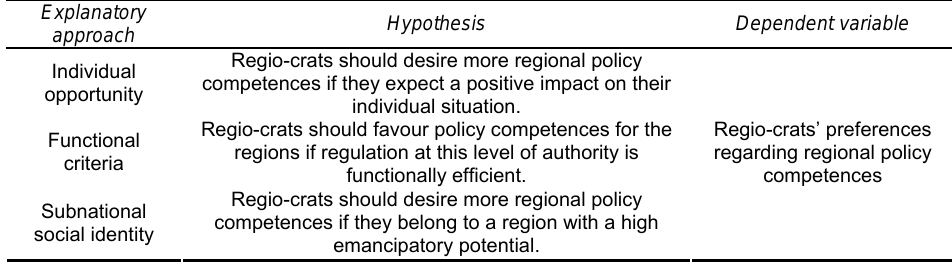
Table 1: Explanatory approaches and respective hypotheses Explanatory